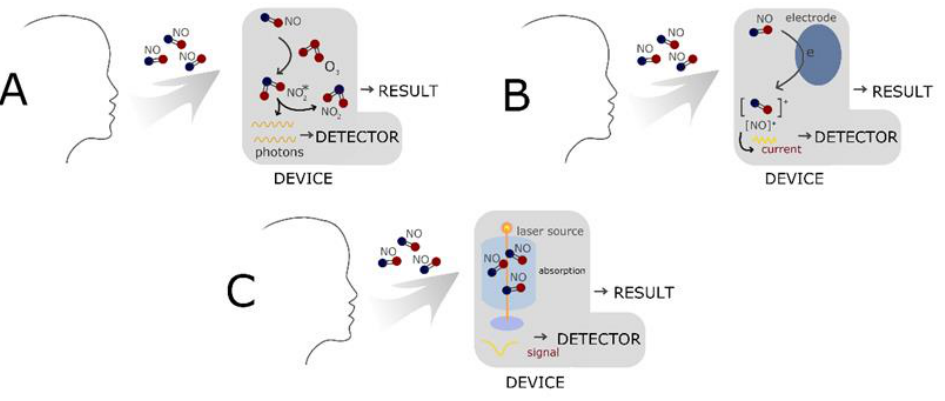
Figure 2. Methods of measuring NO in exhaled air: ( A ) electrochemistry, ( B ) chemiluminescence, and ( C ) laser technology.